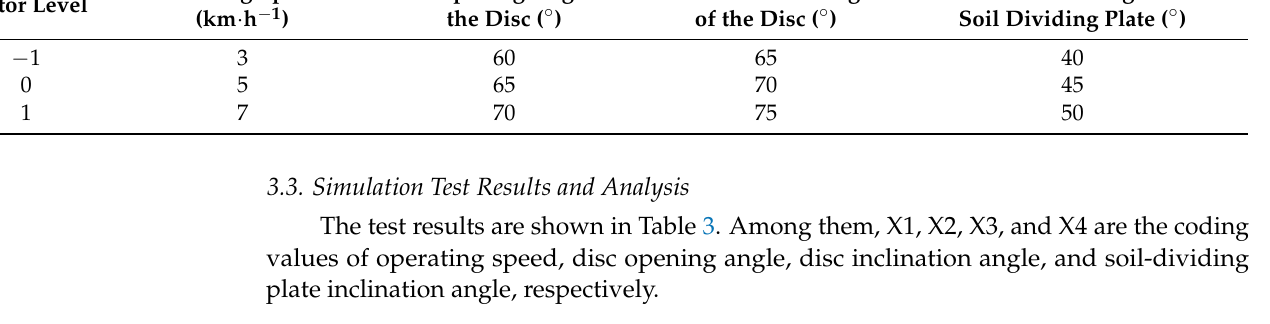
Table 3. Scheme and Results of Quadratic Orthogonal Rotation Regression Combination Test of Soil-covering Device Operation